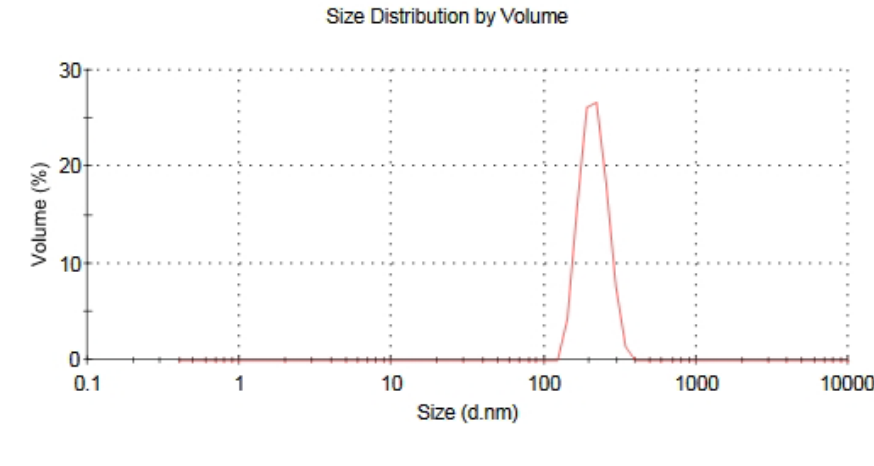
Figure 6. Particle size distribution of nano-TiO